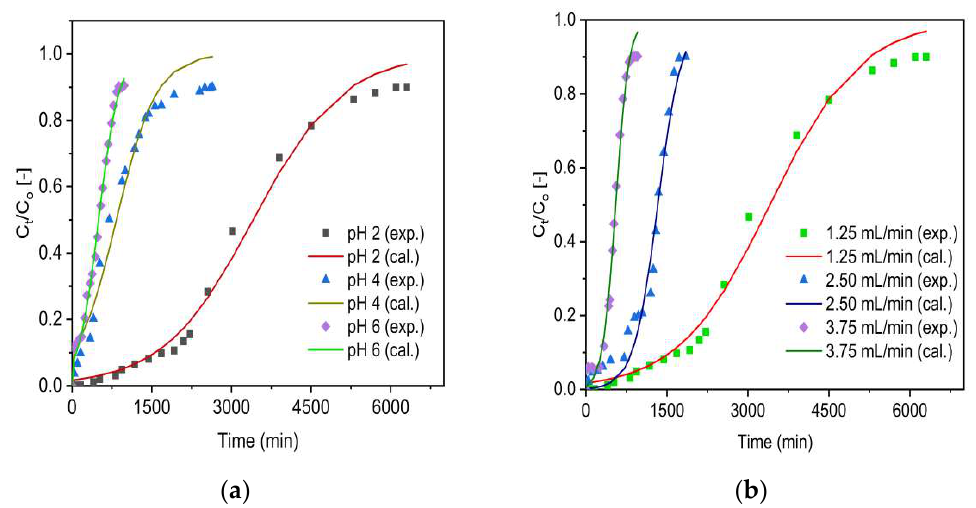
Figure 7. Experimental (exp.) and simulated (cal.; Thomas model) breakthrough curves of fluoride for ZrOCSc at different ( a ) pH (C O : 10 mg/L; Q O : 1.25 mL/min; bed depth 10 cm) and ( b ) initial flow rate, Q O (pH 2; C O : 10 mg/L; bed depth 10 cm).